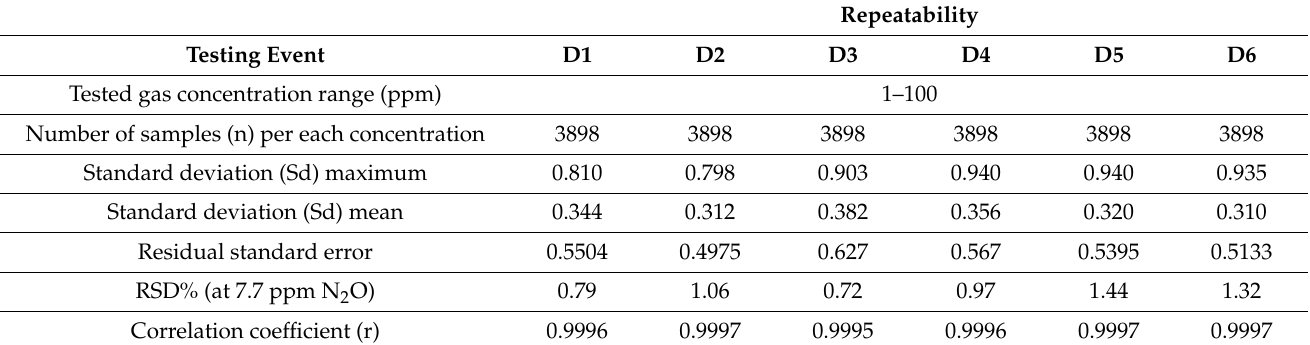
Table 1. Results of the repeatability test of the new device.